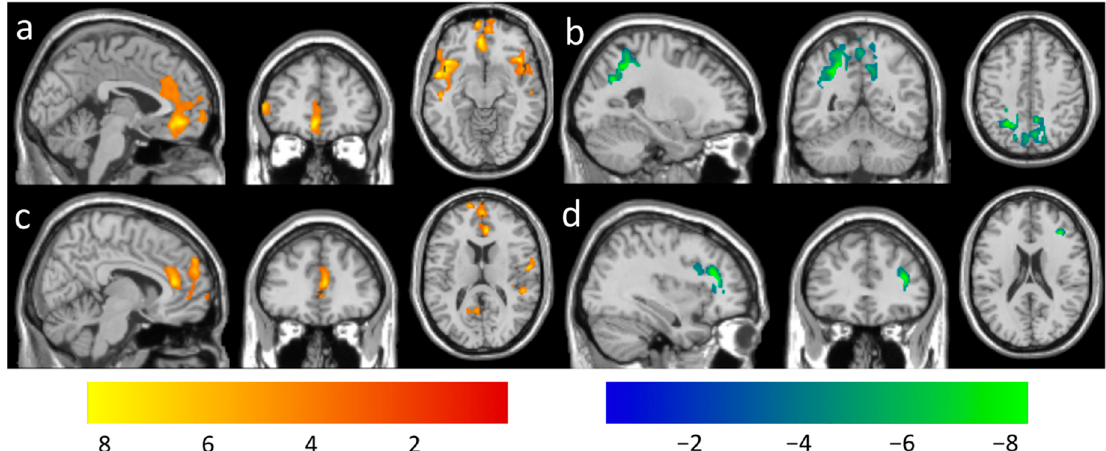
Figure 4. Regions overlaid on a standard brain template in which the meditation practice time was positively associated with functional connectivity with a seed ROI at the ( a ) PCC (peak-T − 54, 4, − 10), ( c ) vmPFC (peak-T 8, 36, 14) and negatively associated with functional connectivity with a seed ROI at the ( b ) PCC (peak-T − 26, − 52, 42), ( d ) vmPFC (peak-T 36, 34, 18) at the thresholds of a voxel-level p -value of 0.005 and corrected cluster-level p -value of 0.05. The color bar shows the range of t -values. Table 3. Summary of cluster-level statistics for clusters showing significant longitudinal FC changes associated with med- itation practice time.